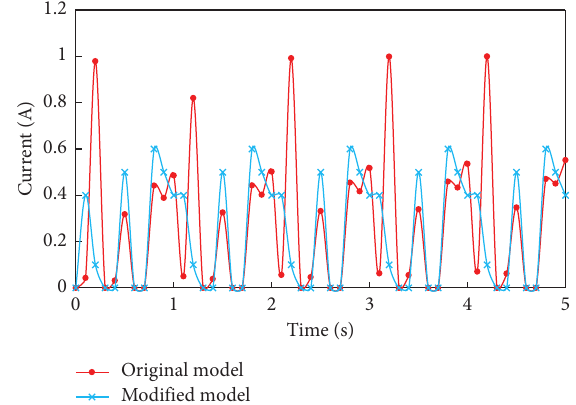
Figure 22: Control current for two kinds of